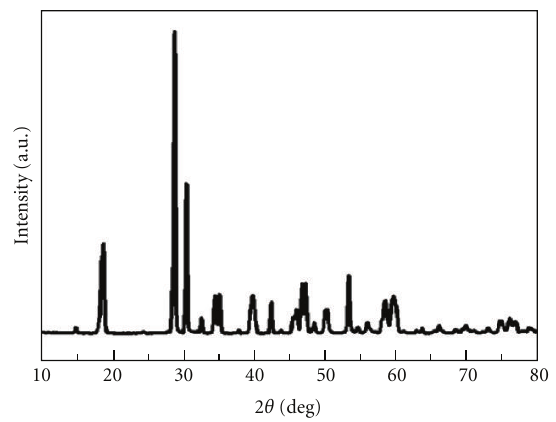
Figure 2: XRD pattern of the as-prepared mesoporous BiVO 4 nanorods.